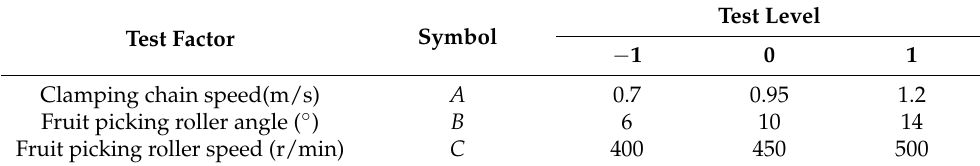
Table 4. Test factors codes.